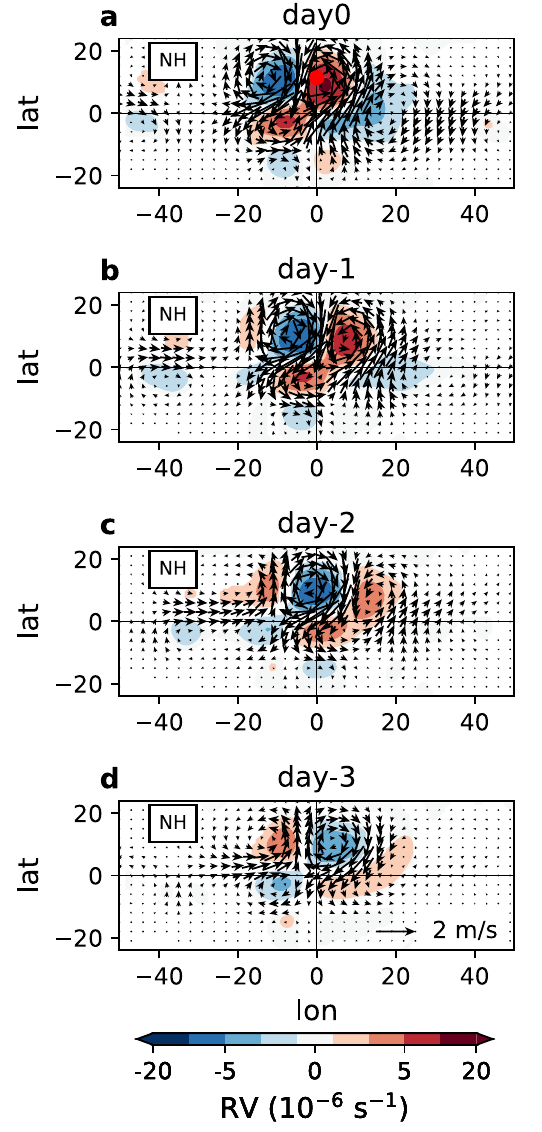
compositeofrelativevorticityofwavewindssigni fi cantatthe95%con fi dencelevel is shown. Winds are combined from WMRG, R1 and R2 wave winds. Red dot shows the averaged latitude of pre-TCG vortex. b – d as a , but for composite means 1 – 3 days before pre-TCG events. e – h as a – d , but with shading showing composite means of relative humidity anomaly at 700hPa (RH, in the units of %). The lower troposphere is equally averaged over 900, 850, 800, 750, and